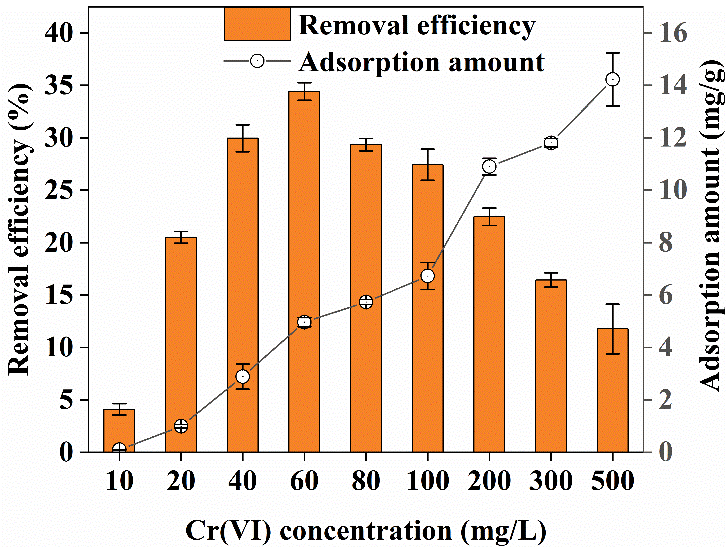
Figure 4. Effect of Cr(VI) concentration on Cr(VI) removal.